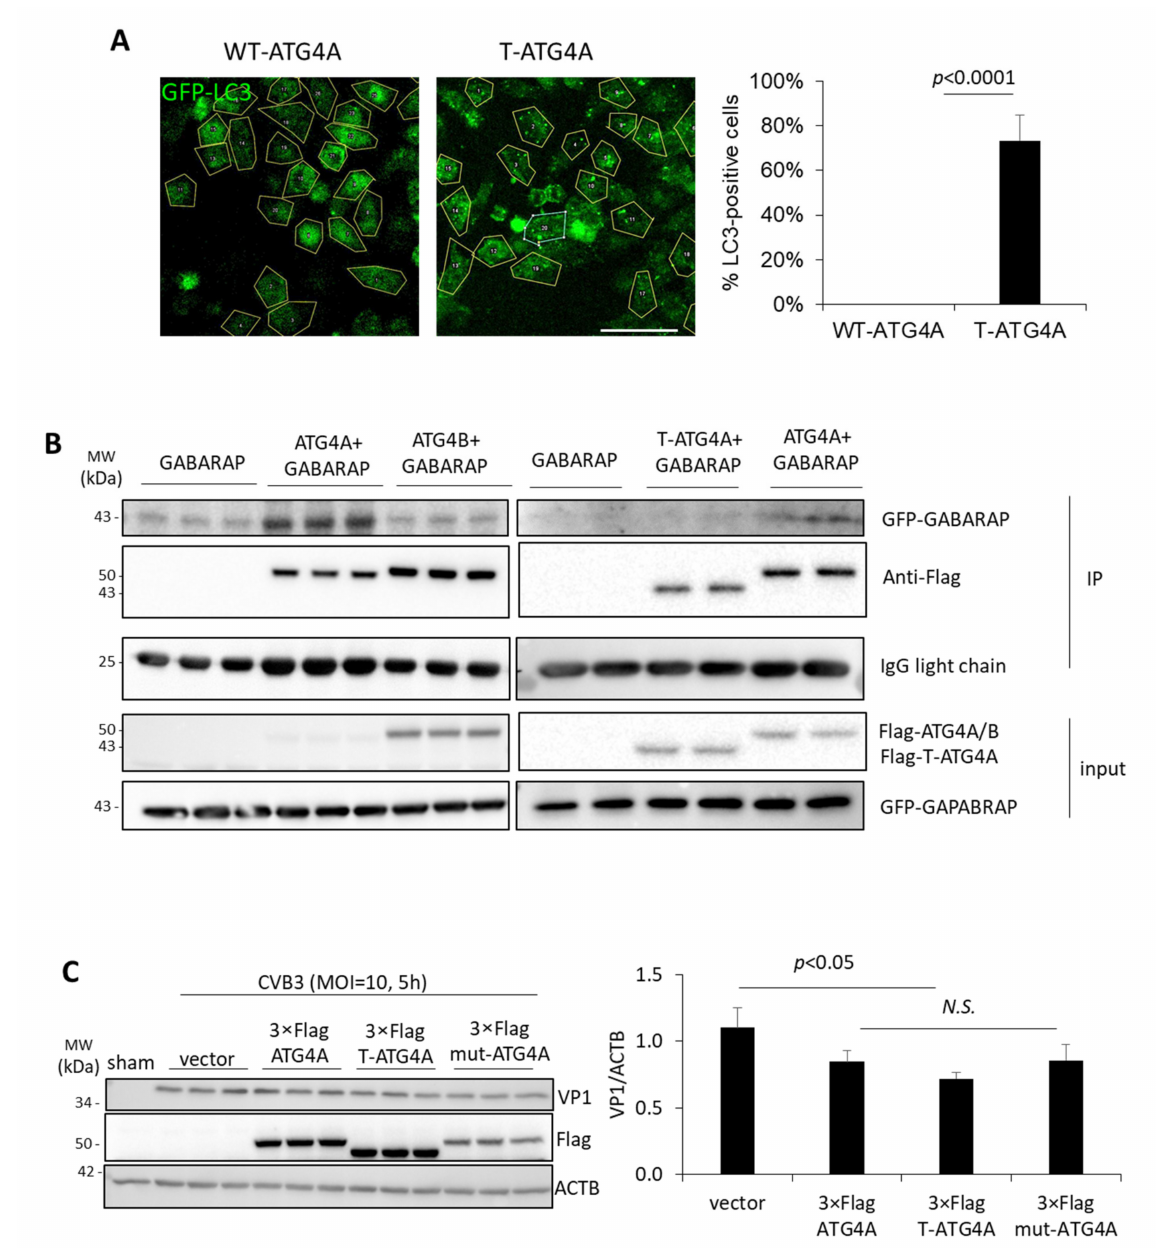
Figure 4. Truncated ATG4A has impaired functional capacity. ( A ) HeLa cells were transfected with GFP-LC3 and either wild-type WT-Flag-ATG4A or T-Flag-ATG4A for 24 h. GFP-LC3 puncta was quantified and presented in right panel as percentage of LC3-puncta positive cells (mean ± S.D., n ≥ 30 cells per condition). Scale bar denotes 10 µ m. Statistical analysis was performed by unpaired Student’s t test. ( B ) HEK293T cells were transfected with GFP-GABARAP alone or in combination with WT-Flag-ATG4A, WT-Flag-ATG4B, or T-Flag-ATG4A. Co-immunoprecipitation (IP) was per- formed with anti-FLAG antibody and subjected to Western blot analysis. IgG light chain was probed as IP loading control. Results in this figure are representative of two to three independent experiments. ( C ) HeLa cells were transfected with either vector control or constructs encoding WT-3 × Flag-ATG4A, truncated 3 × Flag-T-ATG4A, or 3 × Flag-mut-ATG4A for 24 h prior to CVB3 infection (MOI = 10, 5 h). Lysates were subjected to Western blot analysis for anti-VP1, Flag, and ACTB loading control and densitometry quantified on right panel (mean ± S.D., n =